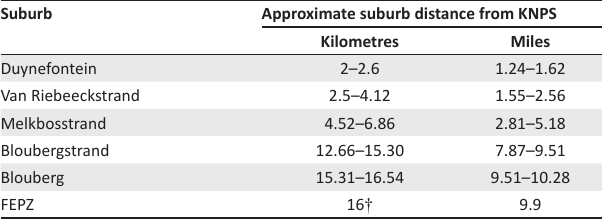
TABLE 1: Approximate distances between Koeberg Nuclear Power Station and the suburbs in Ward